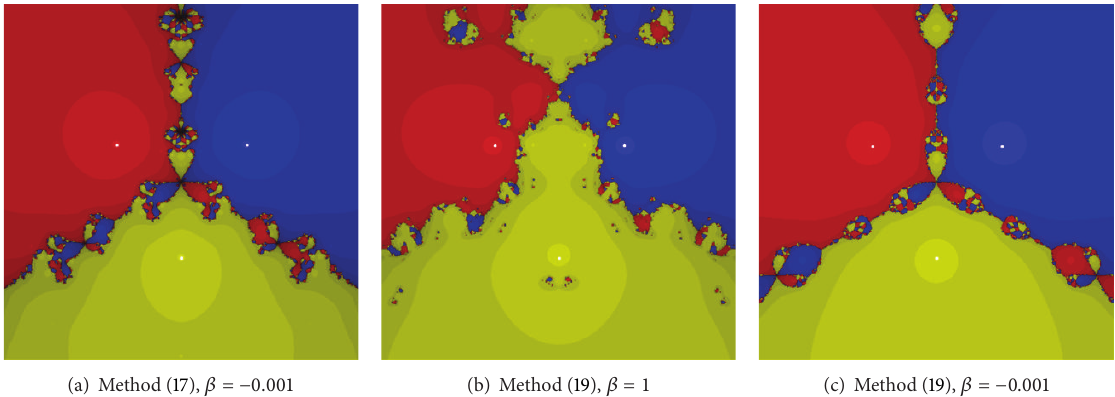
Figure 27: Basins of attraction for the test problem